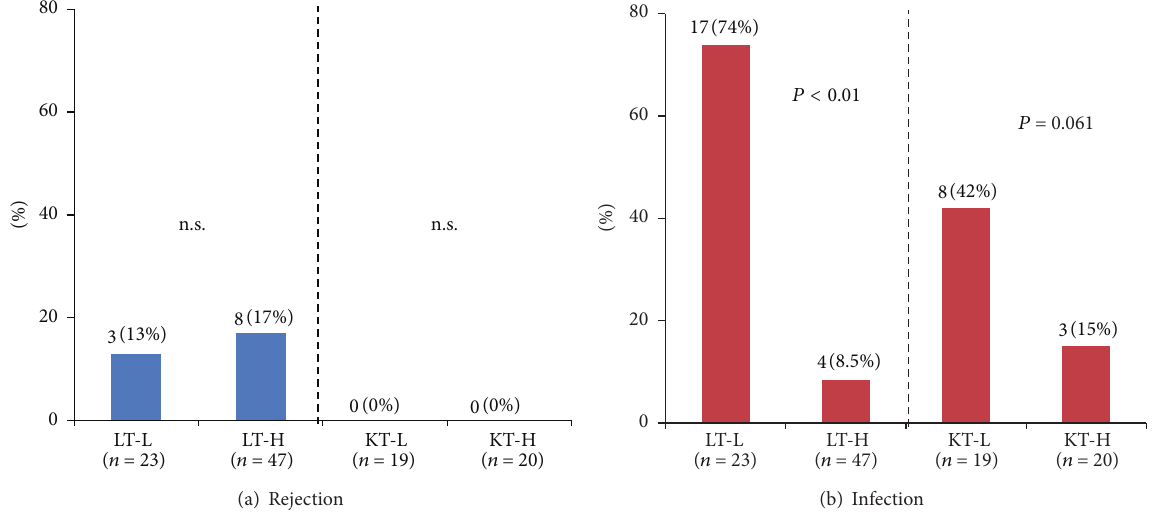
Figure 4: Occurrence of rejection and infection in LT and KT patients. (a) Histologically proven rejection occurred in 3 cases (13%) in LT-L group and in 8 cases (17%) in LT-H group during this survey period. There was no significant difference between the two groups ( 𝑃 = 0.668 ). No rejection occurred in both KT-L and KT-H patients. (b) The incidence of bacterial and/or viral infection was significantly higher in LT-L group (74%) than in LT-H group (8.5%) ( 𝑃 < 0.001 ). Posttransplant infection occurred in 8 patients (42%) in KT-L group compared to 3 patients (15%) in KT-H group ( 𝑃 = 0.061